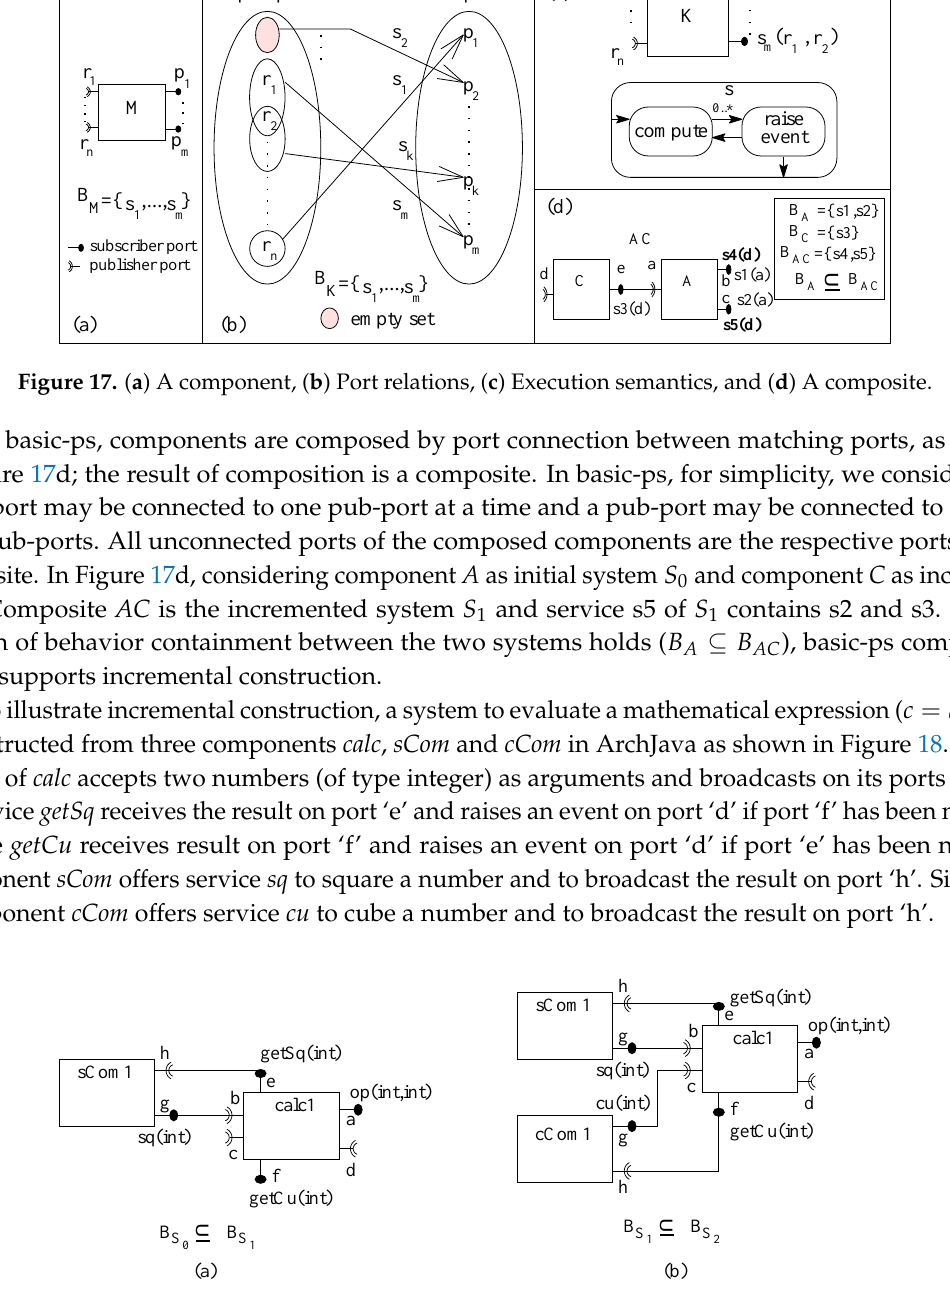
Figure 18. A basic-ps component model system in ArchJava: ( a ) First system and ( b ) Second